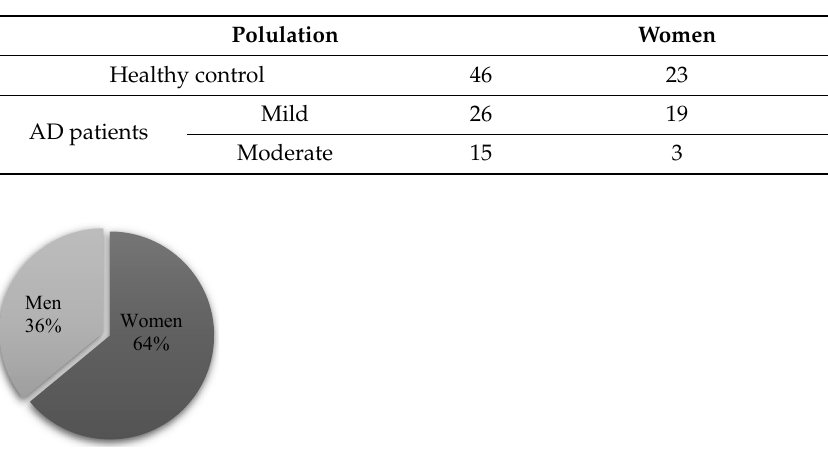
Table 2. Distribution of the people recorded according to sex, presence or absence of AD and the comparison between the different degrees analyzed (HC subjects, mild or moderate patients).